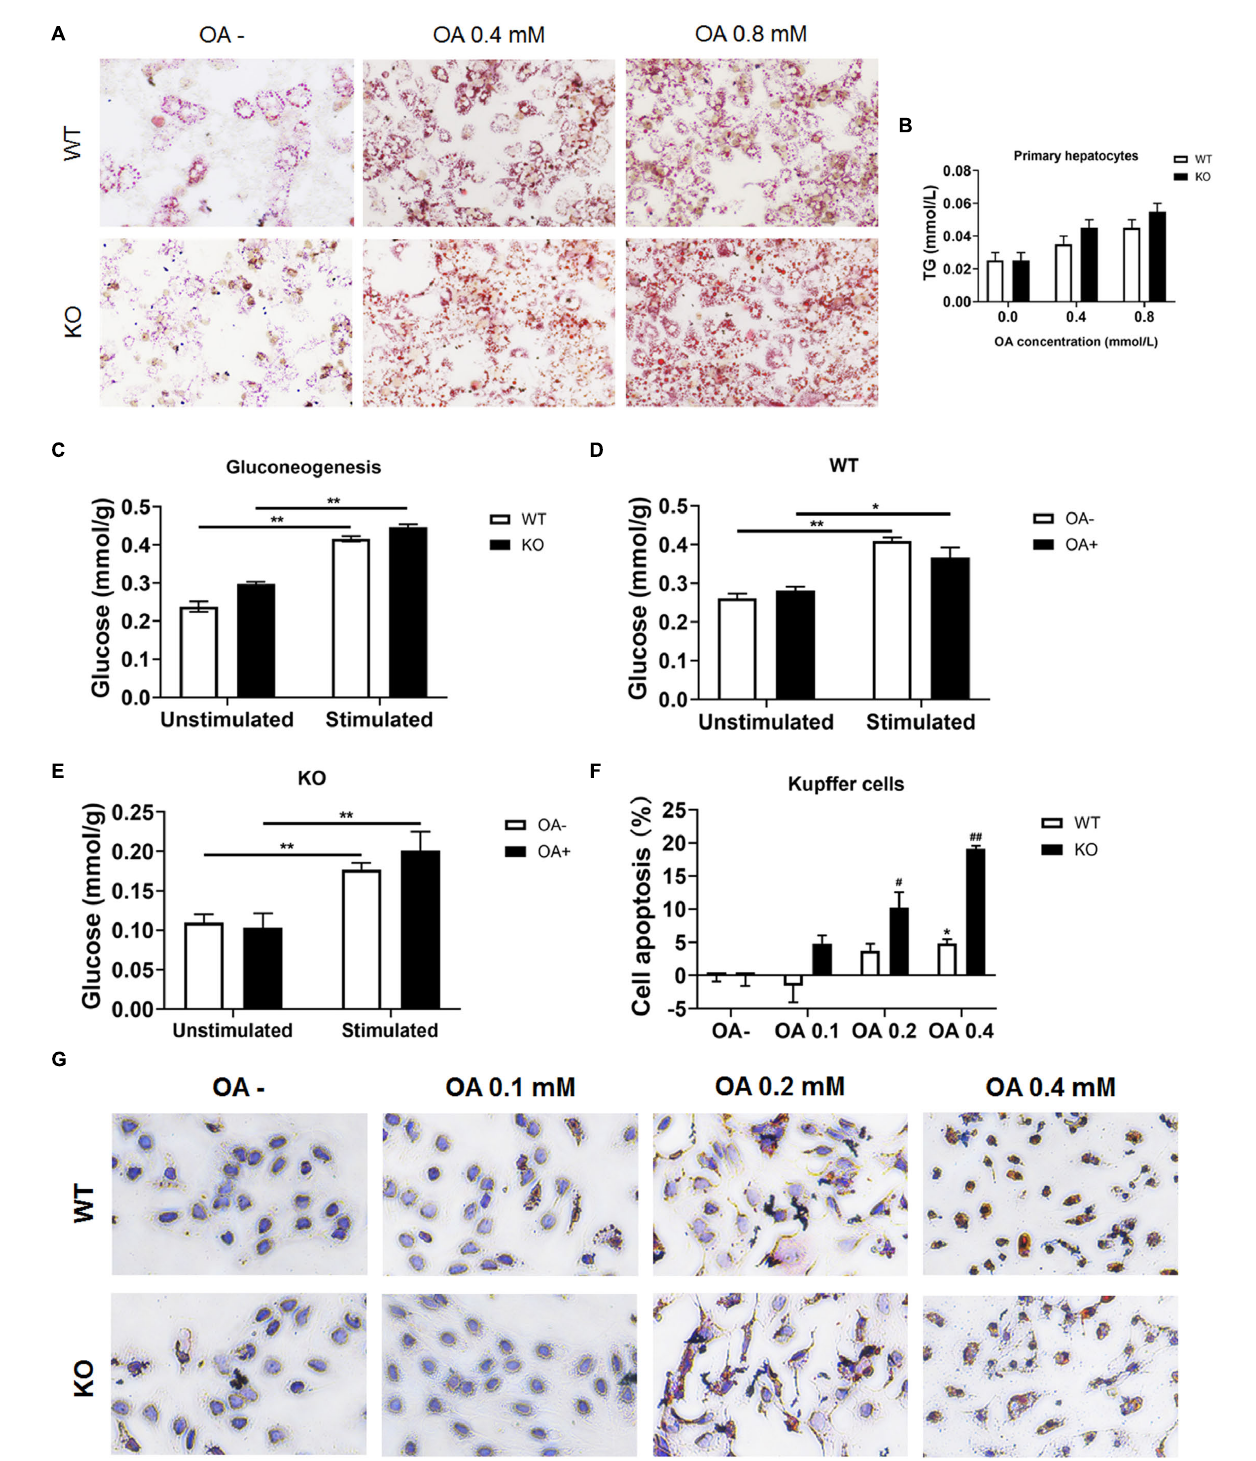
FIGURE 7 | LAMTOR1 deficiency reduces lipid tolerance of Kupffer cells. (A) Red O staining of murine primary hepatocytes after incubation with 0, 0.4, and 0.8 mmol/L OA for 24 h. (B) Intracellular TG levels in primary hepatocytes after OA (0, 0.4, and 0.8 mmol/L) treatment. (C) Gluconeogenesis in the primary hepatocytes of WT and KO mice. (D,E) Gluconeogenesis in the primary hepatocytes of WT (D) and KO (E) mice in the presence of 0 or 0.8 mmol/L OA for 24 h. (F) CCK8 results in the context of Kupffer cells incubated with 0, 0.1, 0.2, and 0.4 mmol/L OA for 24 h (presented as cell apoptosis%). (G) Red O staining of murine Kupffer cells after incubation with 0, 0.1, 0.2, and 0.4 mmol/L OA for 24 h. The data expressed as the mean ± SEM. * P < 0 . 05 vs. WT (C–E) or WT OA- (F) ; ** P < 0 . 01 vs. WT (C–E) or WT OA- (F) ; # P < 0 . 05 vs. KO OA-; ## P < 0 . 01 vs. KO OA-. KO, myeloid-specific knockout mice; OA, oleic acid; WT, wild-type.